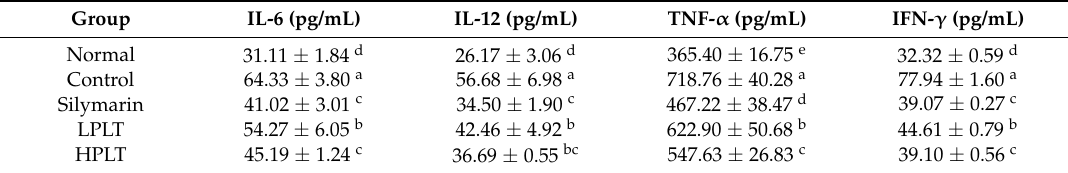
Table 7. Cytokine interleukin (IL)-6, IL-12, tumor necrosis factor- α (TNF- α ), and interferon- γ (IFN- γ ) levels in experimental mice with CCl 4 -induced hepatic damage.